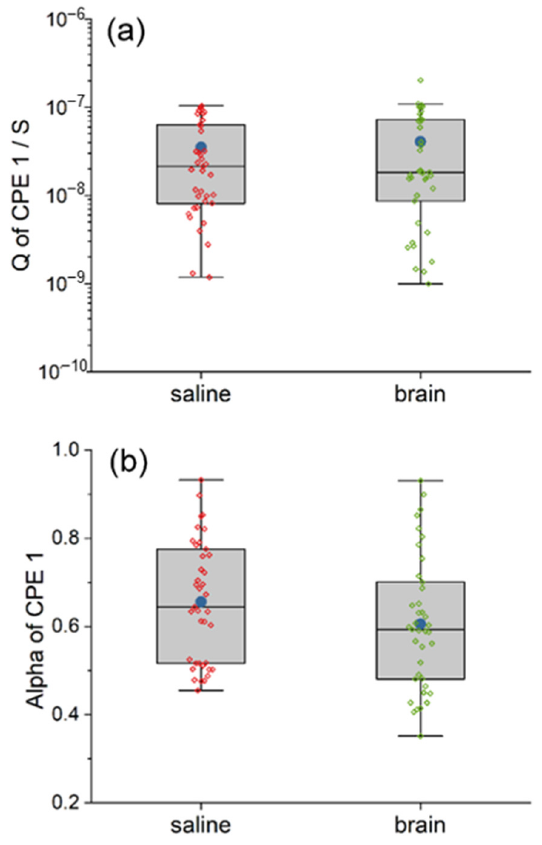
Figure 5. The comparison between the equivalent circuit model of saline and pig brain in the fitted value of Q ( a ) and alpha ( b ) of CPE1. The CPE1 in the two models are similar, indicating similar pseudo-capacitance.